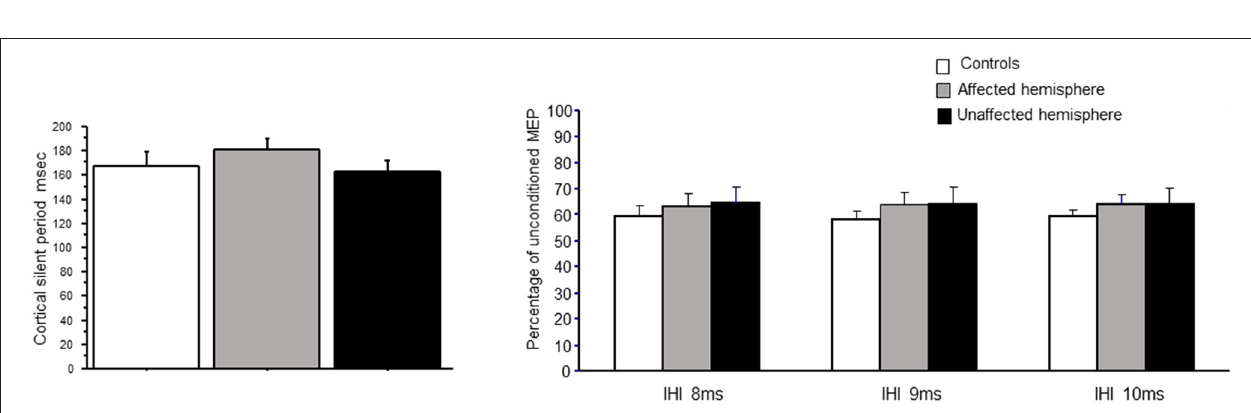
FIGURE 5 | CSP and IHI at 7, 8, and 9ms in controls and patients with brain tumors (affected and unaffected